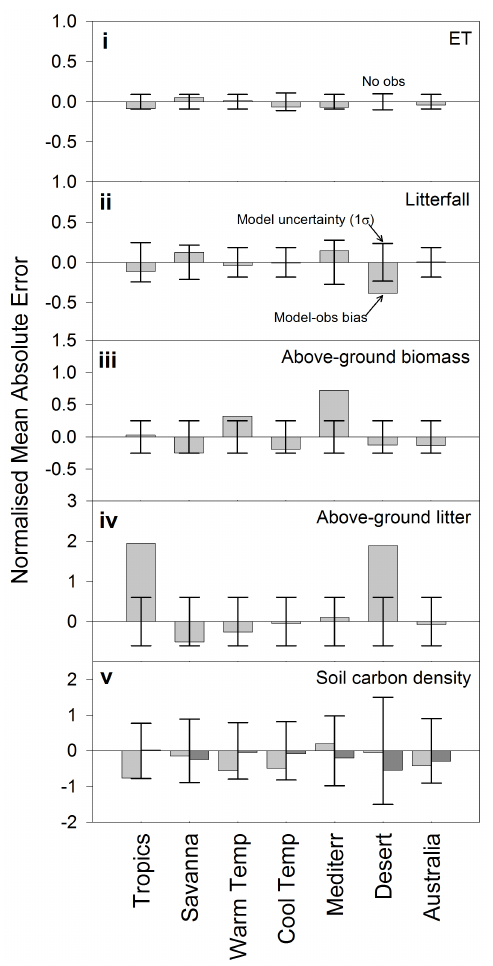
Fig. 16. Normalised mean absolute error (bias) in predictions of long-term (i) catchment-scale ET derived from streamflow; (ii) leaf NPP; (iii) above-ground biomass; (iv) litter carbon; (v) soil carbon density with respect to observations, and corresponding uncertainty estimate in long-term model predictions of observables, aggregated to spatial means for each bioclimatic region and for the whole of Australia.